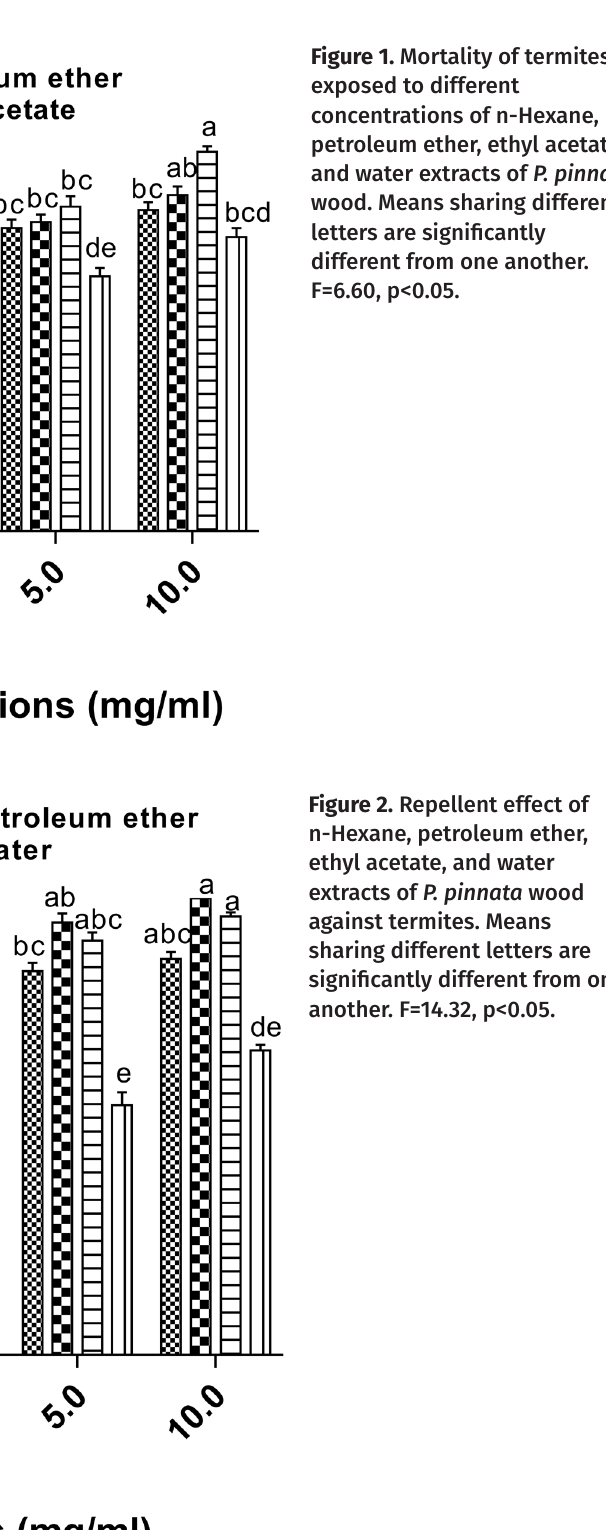
Figure 2. Repellent effect of n-Hexane, petroleum ether, ethyl acetate, and water extracts of P. pinnata wood against termites. Means sharing different letters are significantly different from one another. F=14.32, p<0.05.